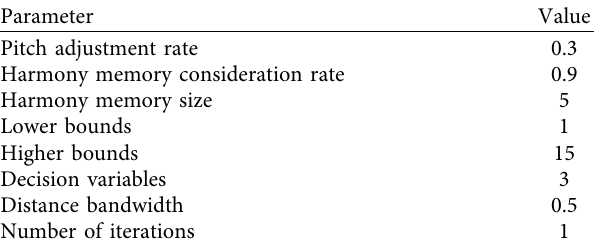
Figure 7: The selected area of Bangi in Malaysia for the experimental simulation scenario. Table 3: Parameterization of